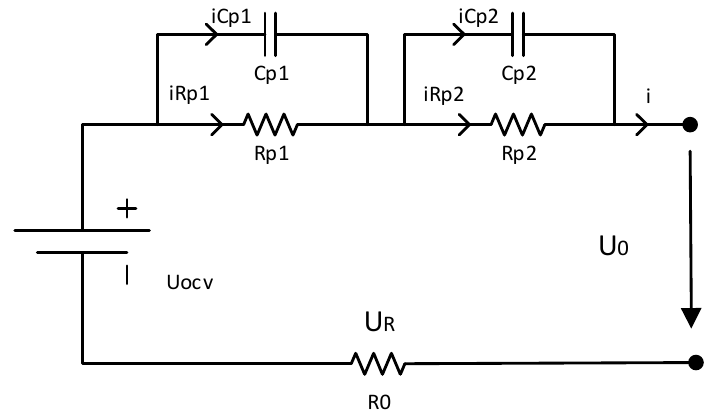
Figure 1. Second-order RC battery model.